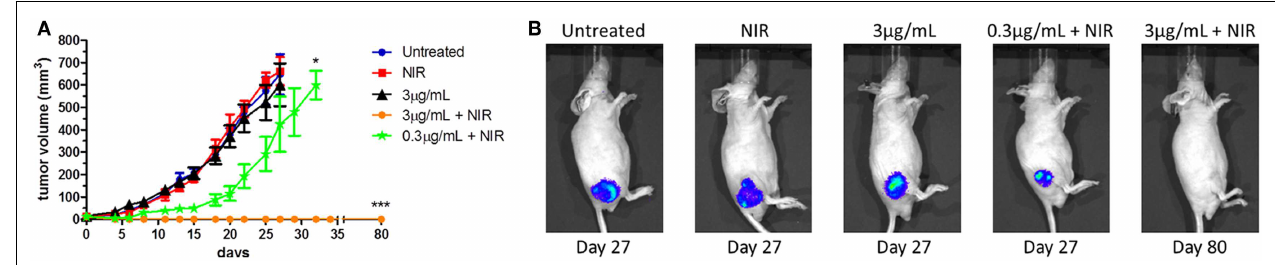
groups (untreated, treated with CNTs alone, or treated with NIR alone) were statistically identical. Only treatment with CNTs (3 µ g/mL) + NIR showed tumor remission ( n = 4; * p < 0.05, *** p < 0.001 relative to untreated group). (B) Representative images of mice at day 27 exhibited tumors. By contrast, animals treated with CNTs (3 µ g/mL) + NIR group did not show any tumor ( n = 4) even at the termination of the experiment (day